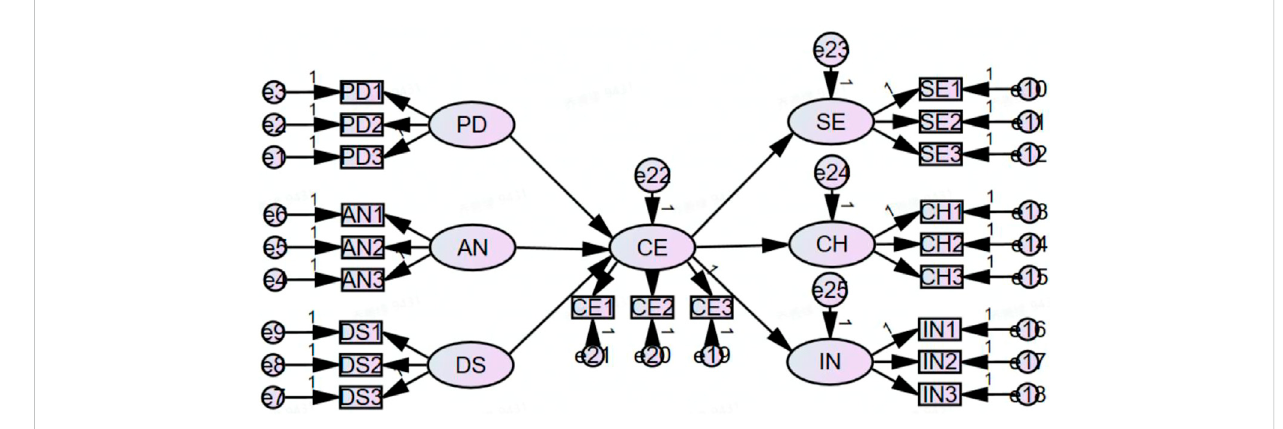
FIGURE 2 Structural equation model.